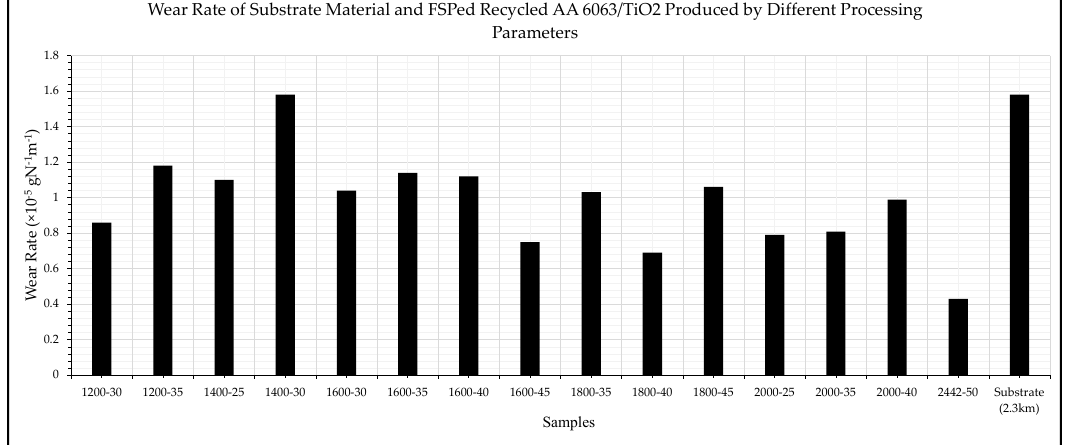
Figure 19. Wear rate for substrate material and FSPed samples after sliding for 2.5 km subjected to a nominal contact pressure of 0.24 MPa at a sliding speed of 2.88 m/s under starved lubrication conditions.